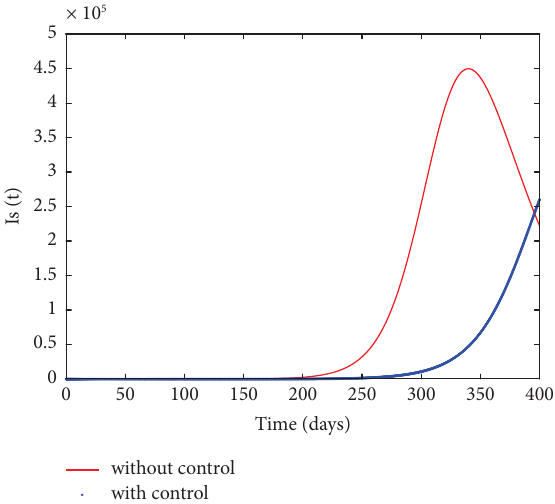
Figure 12: Behaviour of the symptomatic individuals with and without the